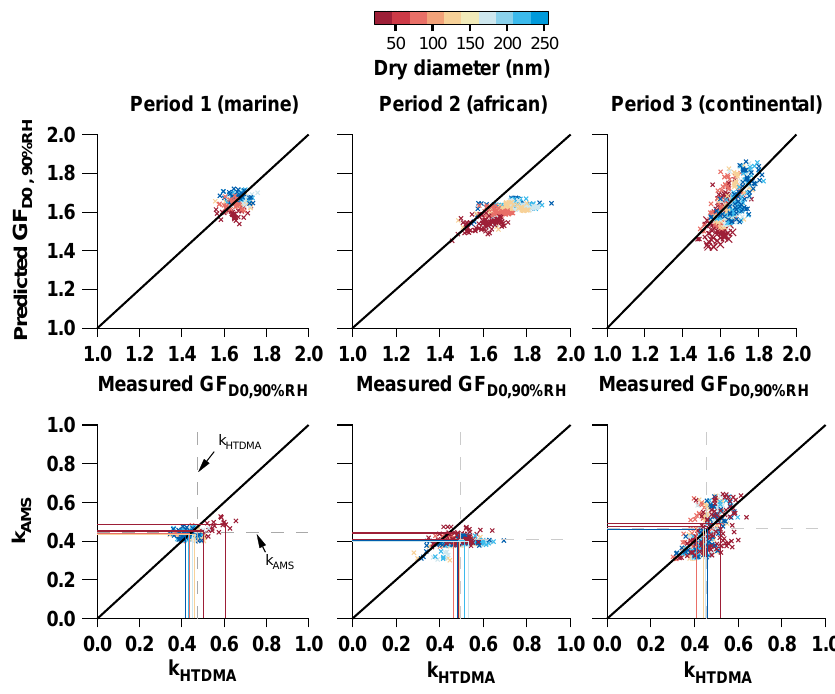
Fig. 5. Measured and predicted growth factors. The top panels show the predicted growth factors plotted against the measured growth factors at each measurement interval for the 3 study periods (marine, african and continental). The coloured lines show the average κ values for each dry size. The grey lines show the averaged κ values for the entire period. The bottom panels show the κ values corresponding to the predicted and measured growth factors for the 3